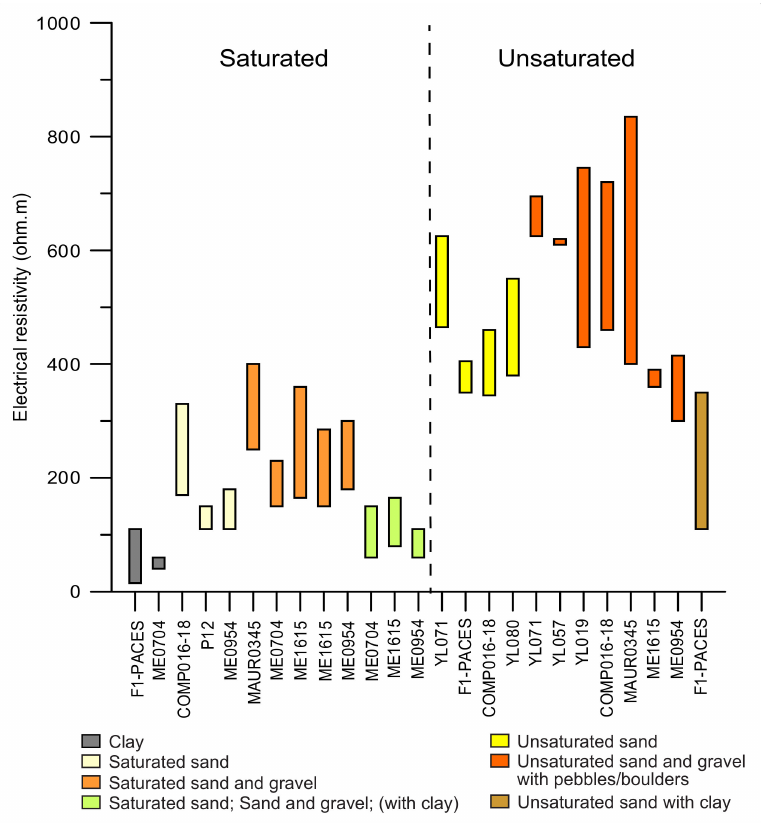
Figure 12. Respective resistivity for the seven sediment classes proposed in the calibration chart. They are deduced from borehole logs to display the minimum and maximum values for each saturated and unsaturated sediment. The horizontal axis represents each of the boreholes and stratigraphic cross-sections and their associated facies. The bedrock is not considered in this